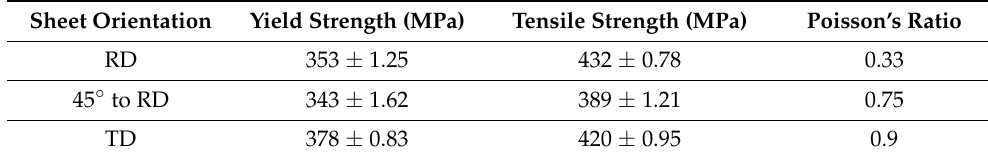
Figure 1. Substrate material properties: ( a ) Microstructure of A-R (CP-Ti50A); ( b ) True stress–strain plot of A-R CP-Ti50A in three directions at room temperature. Table 2. Mechanical properties of A-R CP-Ti50A.